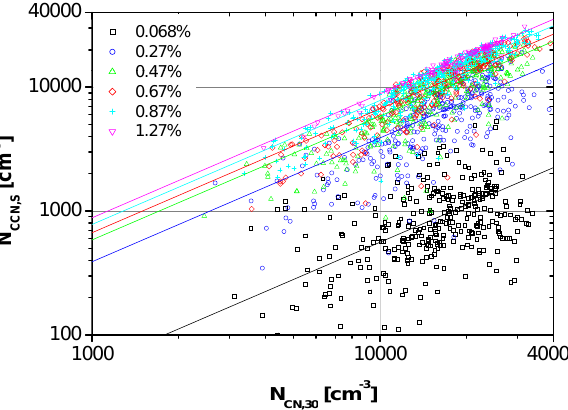
Fig. 9. CCN number concentrations ( N CCN , S ) observed at differ- ent supersaturation levels plotted against the number concentration of aerosol particles with D> 30nm ( N CN , 30 ). The lines are modi- fied power law fits of the function N CCN , S = N CN , 30 · s − q with